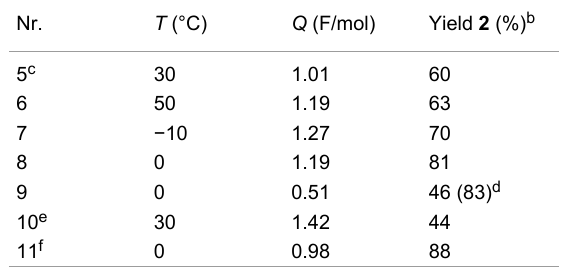
Table 2: Hydrodimerization of 1 a in dependence of temperature, conversion and cell